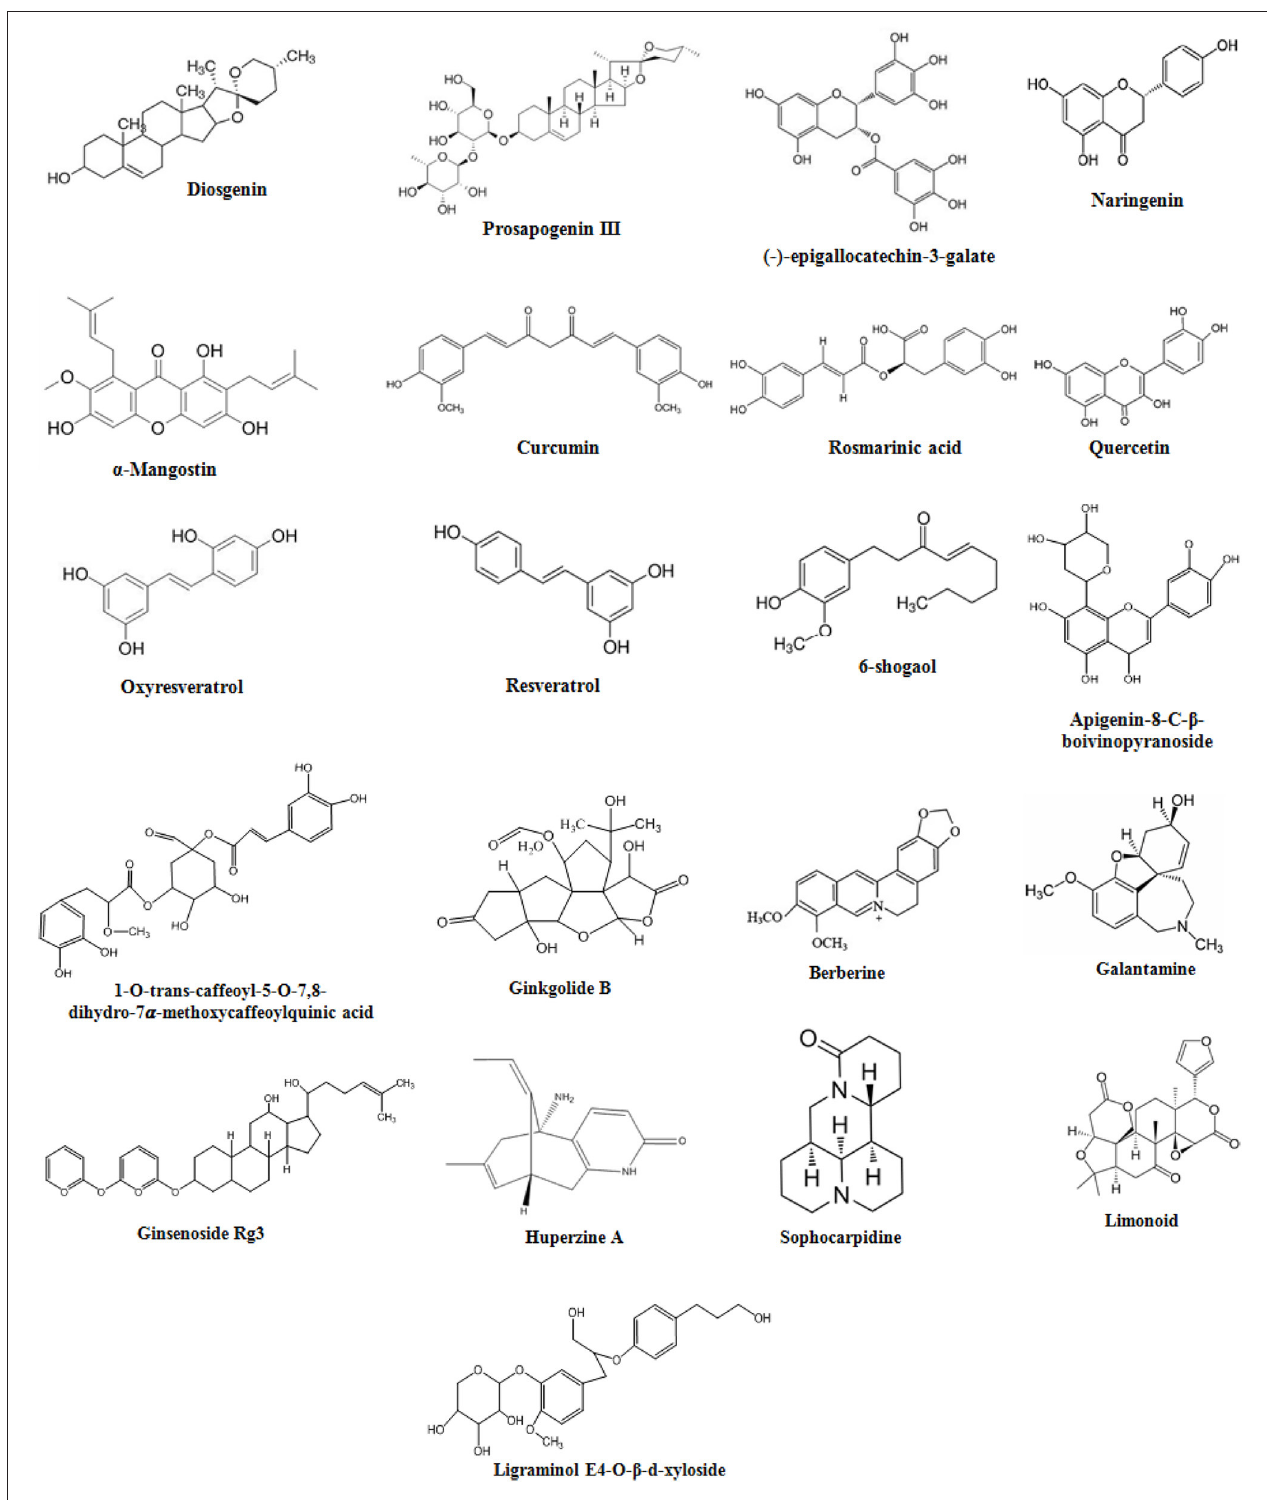
FIGURE 3 | Chemical Structures of natural compounds.